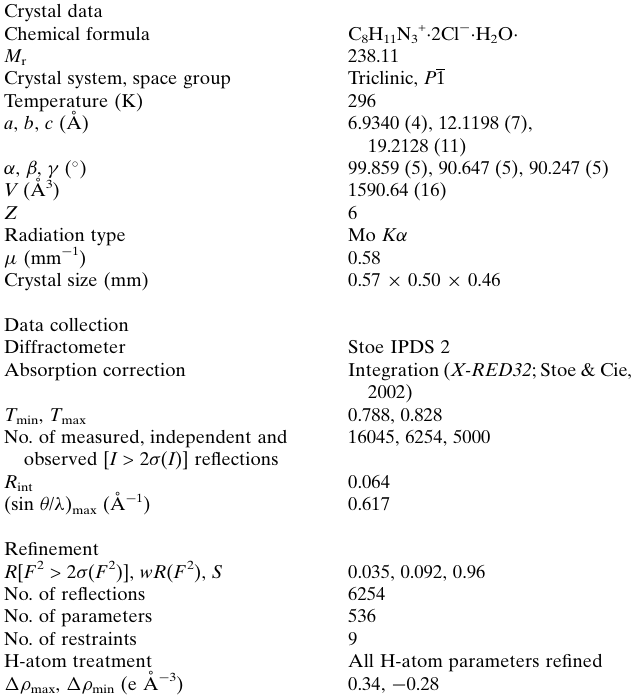
Table 2 Experimental details. Crystal data Chemical